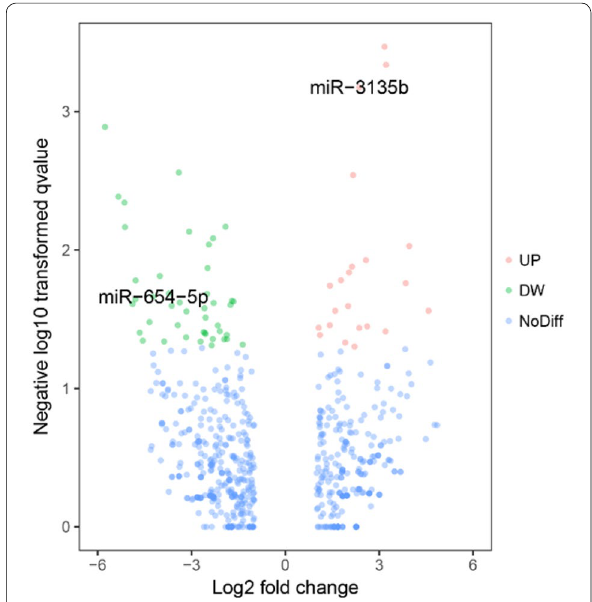
Fig. 5 Volcano plots of differentially expressed miRNAs ( p < 0.05) between LNIV-CC and LNIV (active) groups